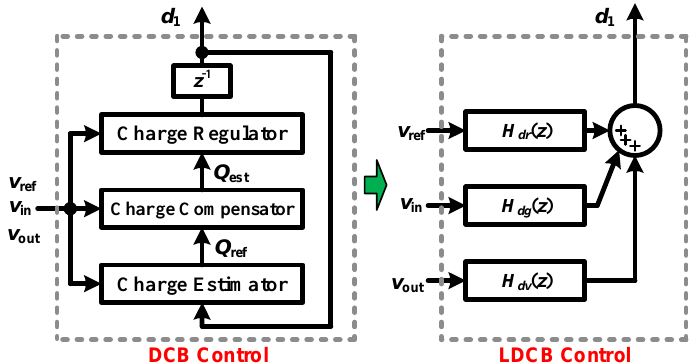
Figure 4. Schemes of conventional discrete charge balance (DCB) controller and the linearized discrete charge balance (LDCB) controller.